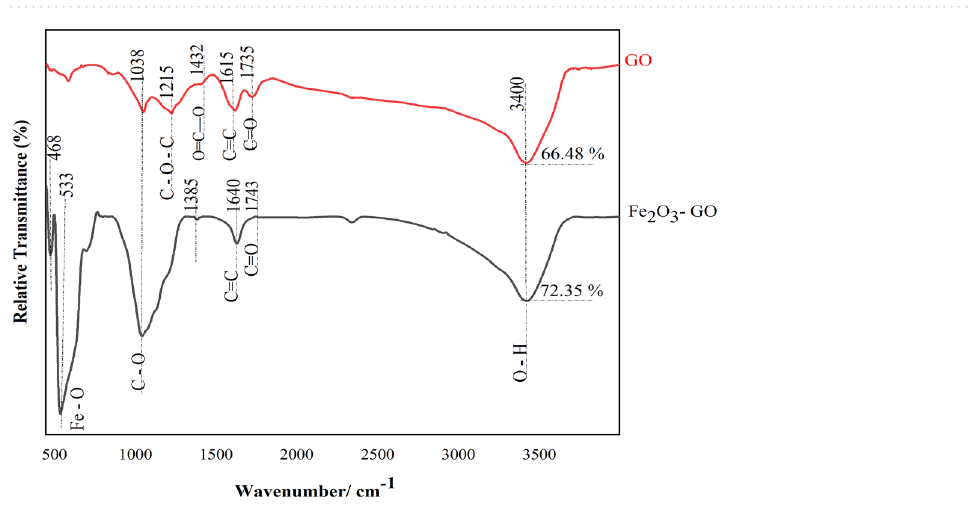
Figure 4. FTIR analysis of GO and Fe2O3-GO